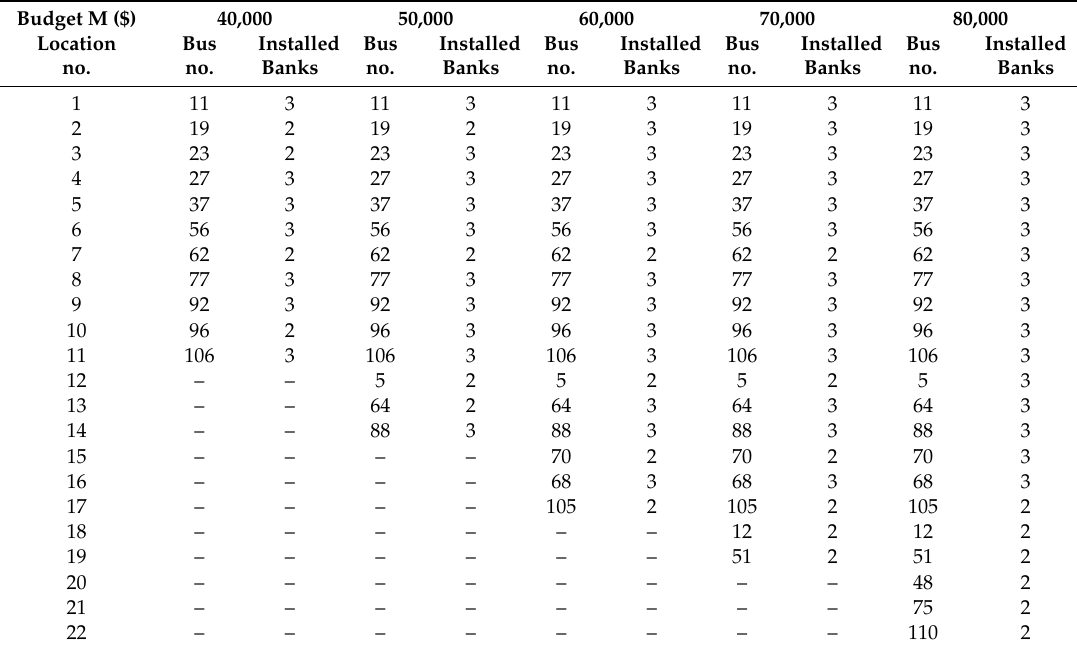
Table 3. Reactive volt-ampere locations and installed banks of the IEEE 118-Bus system. Budget M ($) Location no.